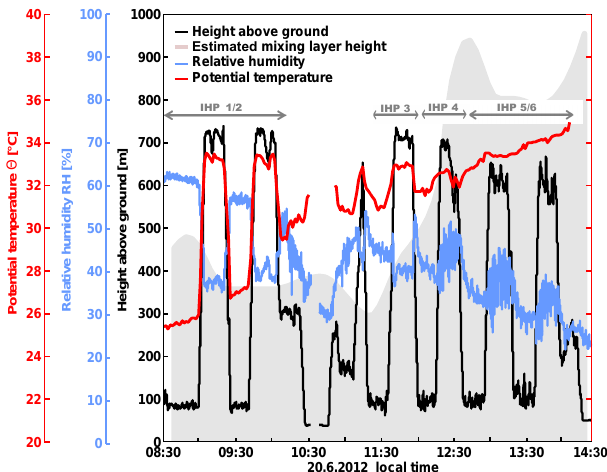
Figure 2. Overview of the flight on 20 June 2012 near San Pietro Capofiume ground station (Po Valley, Italy). In black the flight al- titude and in grey the estimated mixing layer height, determined from ceilometer-Lidar measurements, are presented. The red and blue lines show the potential temperature (cid:50) and RH profiles, re- spectively. In addition, the different height profiles IHP1/2, IHP3, IHP4 and IHP5/6 are